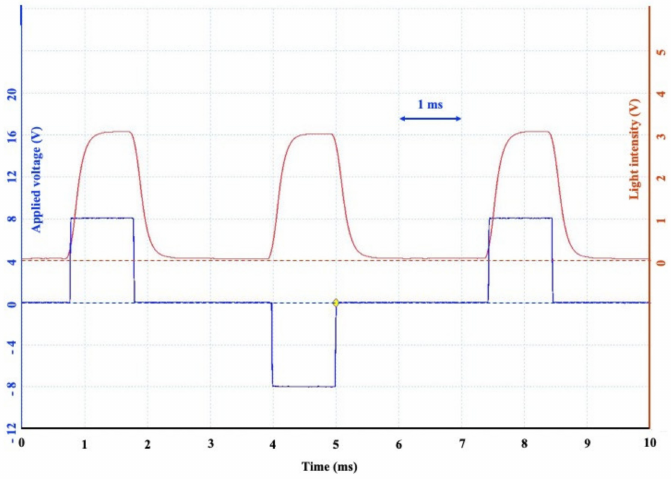
Figure 5. Light-throughput dynamic behavior of the uniformly stacked SSD-LC panel for linearly polarized incident beam.